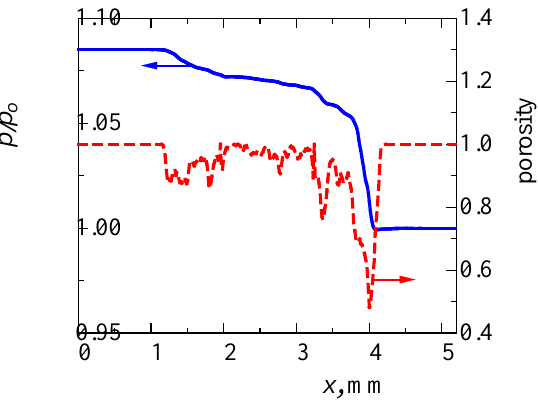
Figure 6. Distributions of pressure and porosity across the